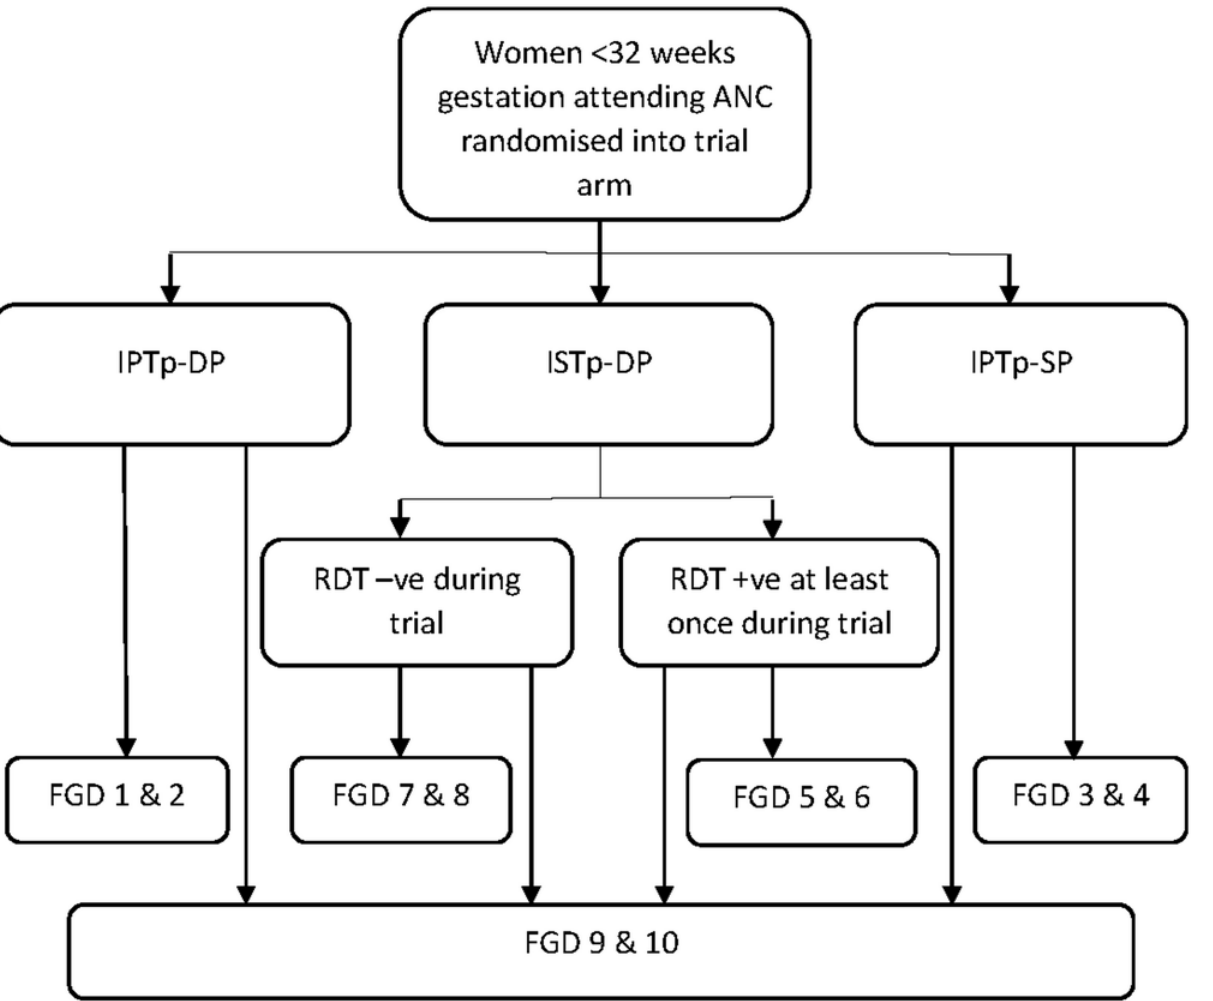
Fig 1. Allocation of trial participants to focus group discussion group by trial